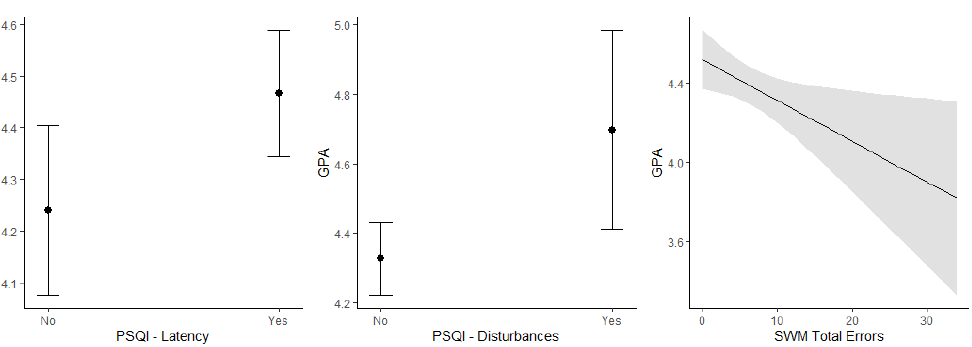
Figure 2. Significant associations between GPA and each component of PSQI (latency and disturbances) and working memory at academic term .